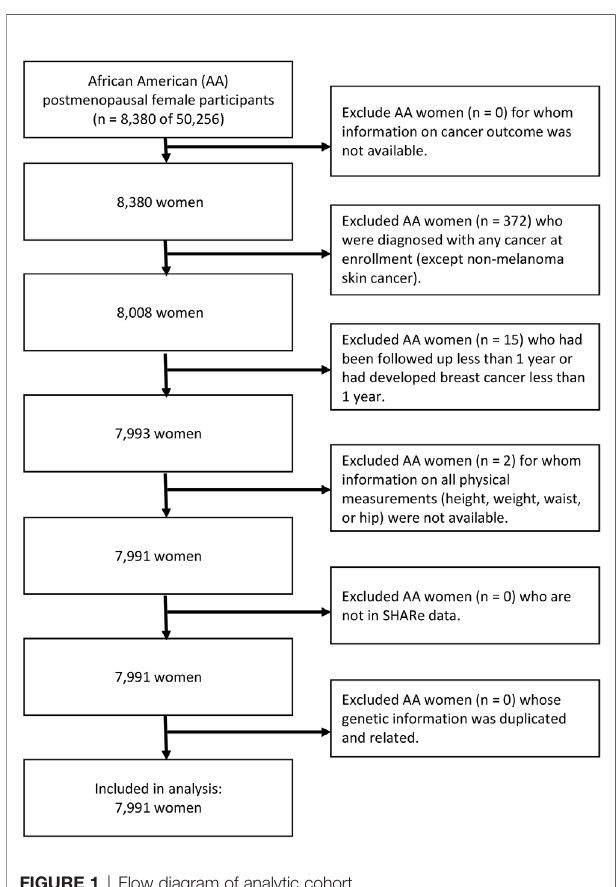
FIGURE 1 | Flow diagram of analytic